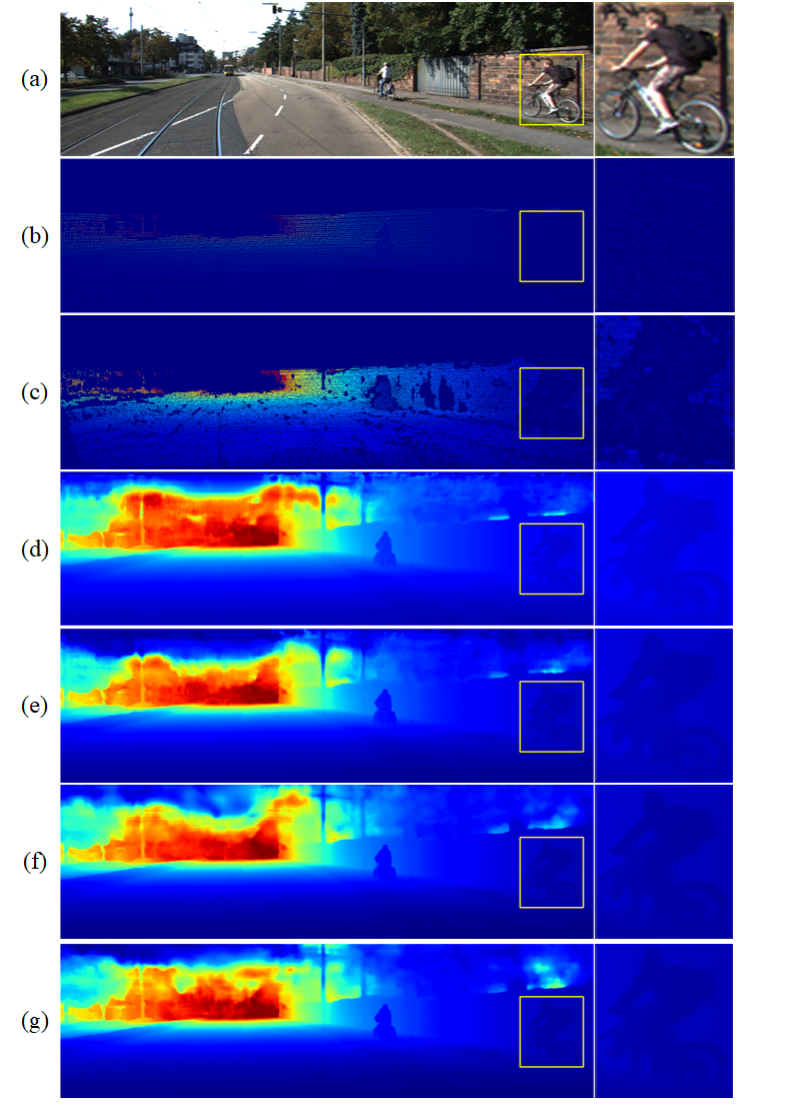
Figure 6. The effect of the depth information completion module where ( a ) is the RGB image, ( b ) is the input sparse depth map, and ( c ) is the ground truth; ( d , e ) are the dense depth map without the depth information completion module, and the rates are 2 and 4; ( f , g ) are the dense depth map when the depth information complement module is added, and the rates are 2 and